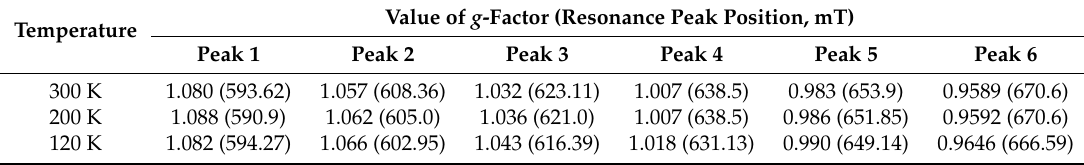
Table 1. Resonance peak position and value of g-factor for bulk FePS 3 single